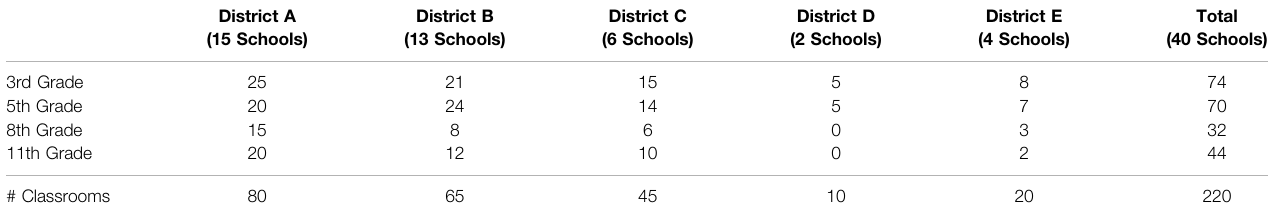
TABLE 1 | Number of sampled classrooms, sorted by grade level and school